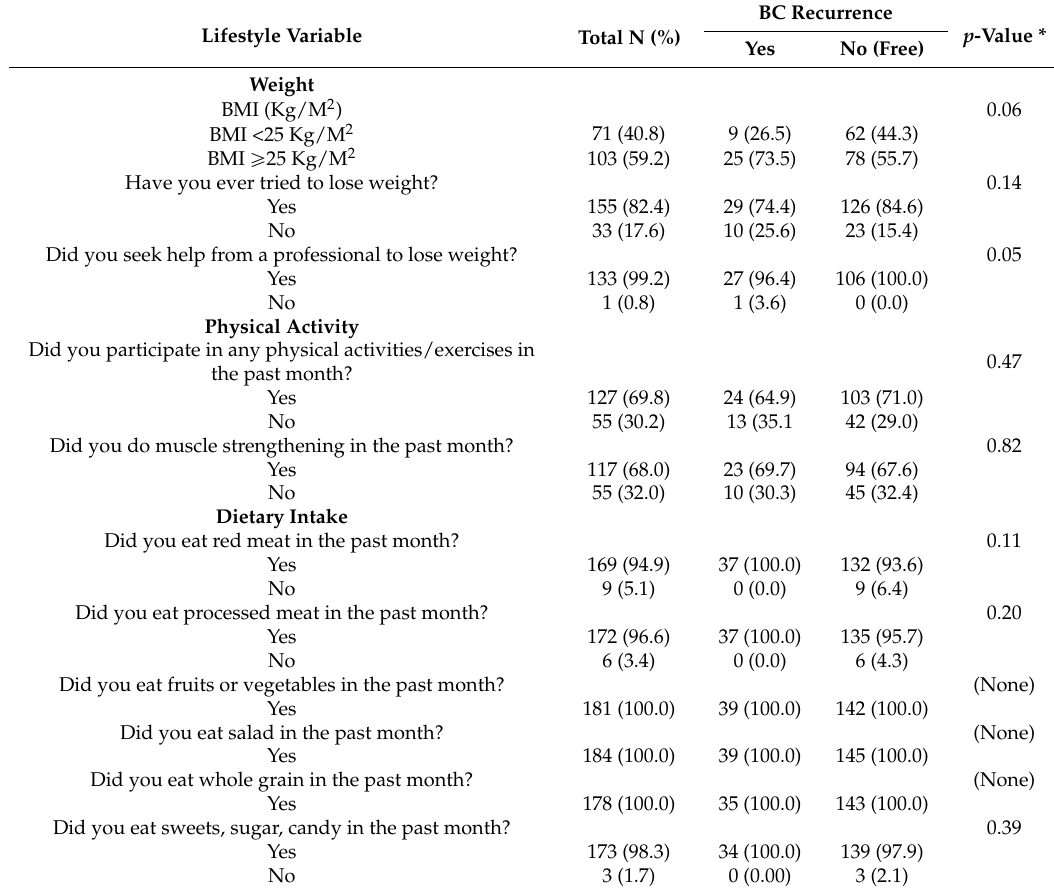
Table 3. Breast cancer recurrence risk reduction behaviors by breast cancer recurrence